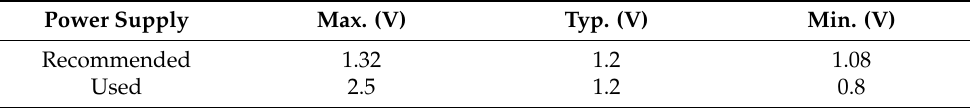
Table 1. Values of the core power supply recommended by the manufacturer and those used for the test.